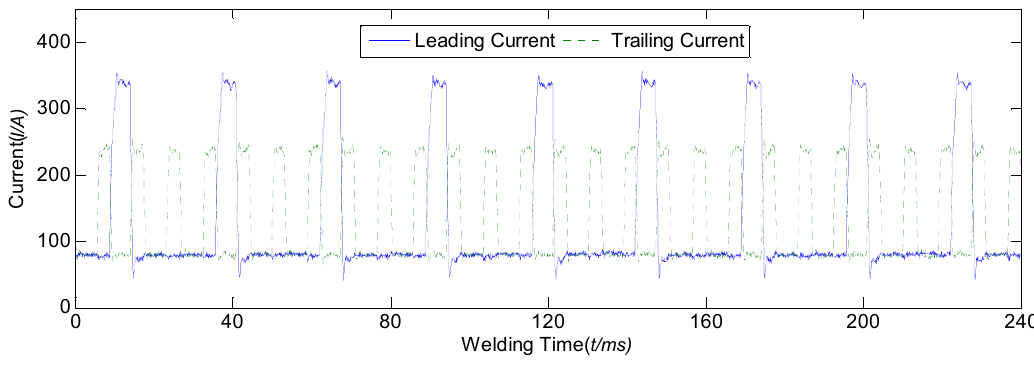
Figure 12. Current waveform under the optimized parameters.